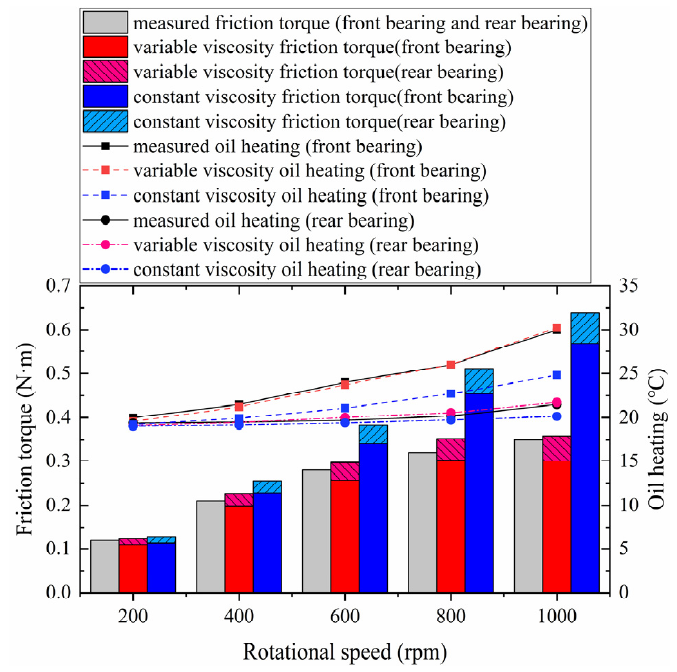
Figure 11. Comparison of the experimental friction torque and oil heating of hydrostatic bearings with their estimation.